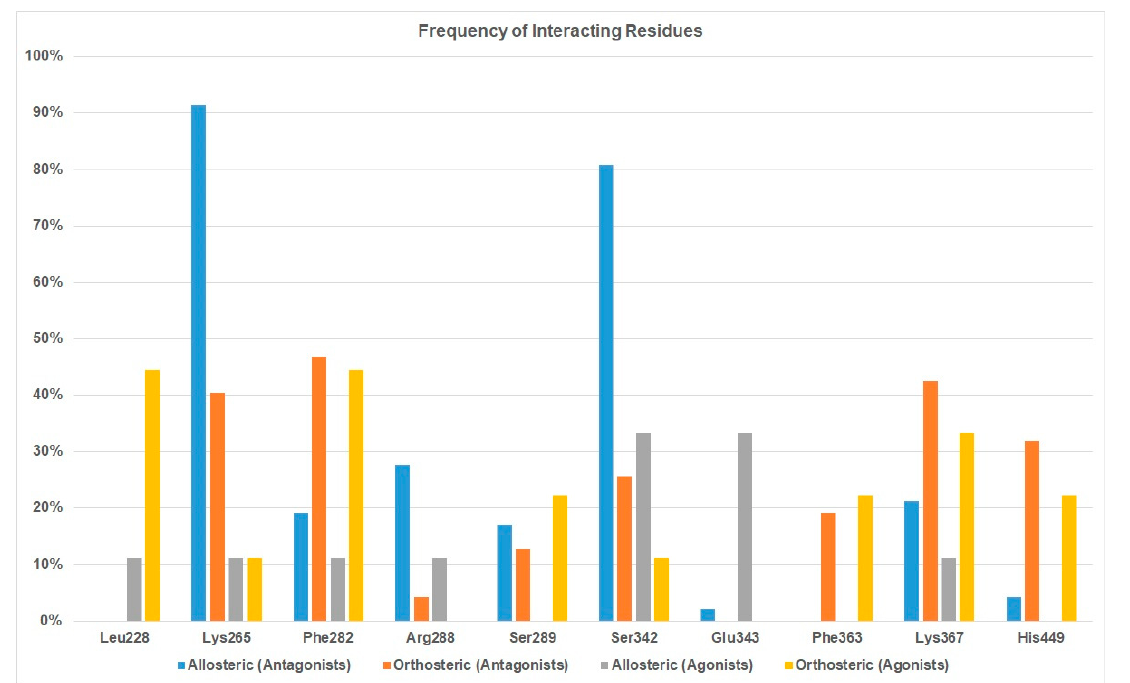
Figure 3. Frequency of interacting residues of PPAR γ antagonists and agonists at the orthosteric and allosteric binding sites.